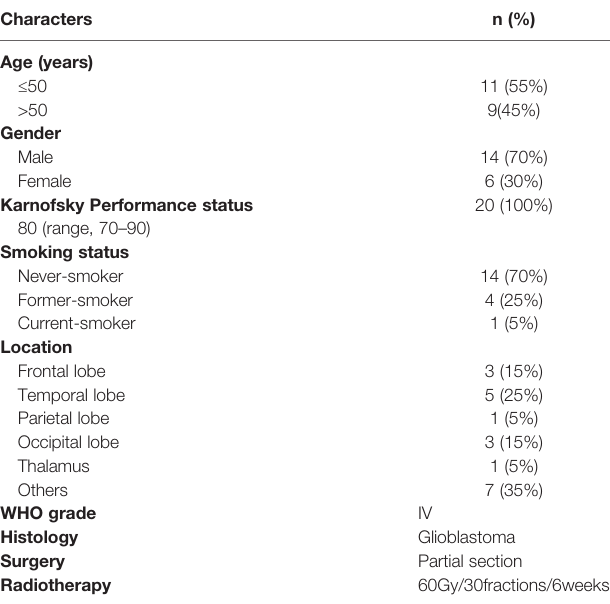
TABLE 1 | Patients ’